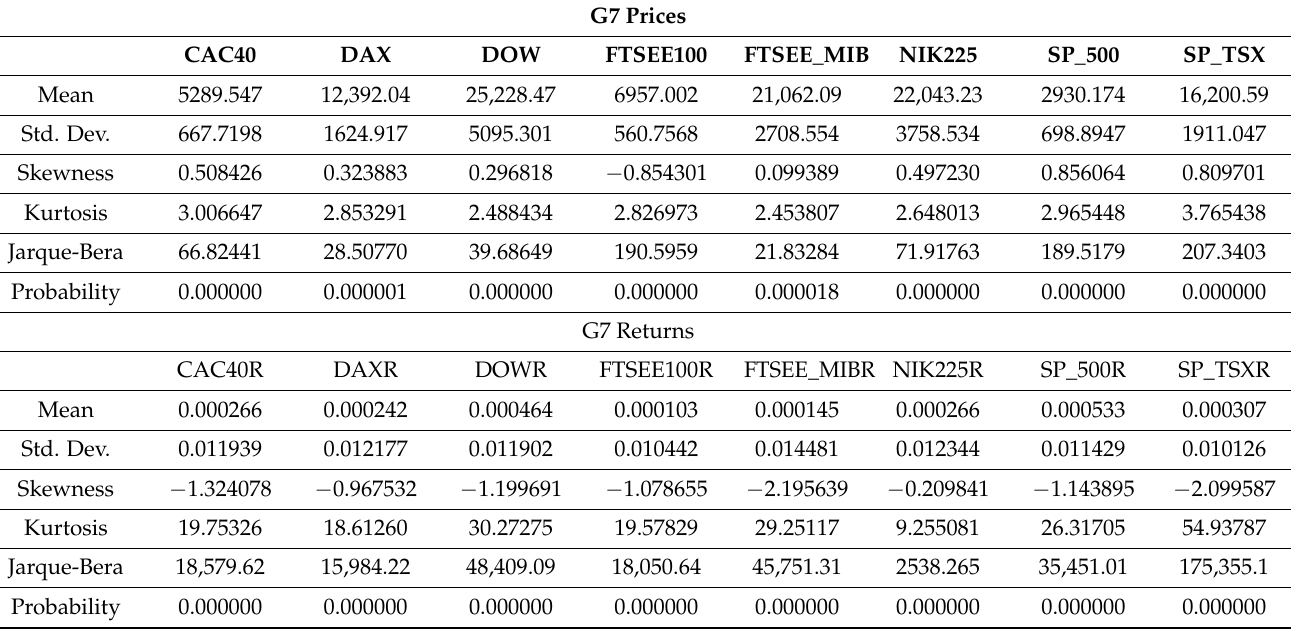
Table 1. G7 Descriptive Statistics.